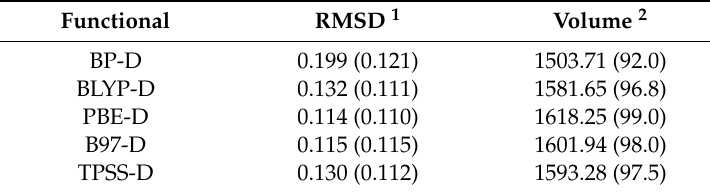
Table 4. RMSD (in Å) in atomic positions for the optimized unit cell of Fc 2 CS relative to the XRD unit cell, and the volume of the calculated unit cell (in Å 3